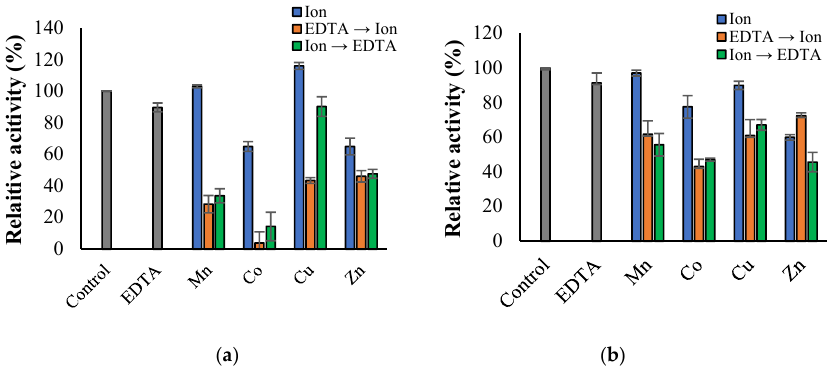
Figure 11. EDTA and metal ion effects on Est2L ( a ), and Est4L ( b ). The enzyme was preincubated with 1 mM EDTA or metal ions for 30 min, then 1 mM metal ions or EDTA were added respectively, and finally enzyme activities were measured. For the lipid hydrolysis activities, Est2L and Est4L hydrolyzed glyceryl tributyrate to 69.0% and 52.8% respectively, followed by trioctanoate to 77.9% and 71.9% respectively (Figure 12). It was confirmed that the hydrolyzing activities of fish oil, olive oil, and glyceryl trioleate by Est2L and Est4L were remarkably low. When based on glyceryl tributyrate as a substrate, Est4L showed a 25.1% higher hydrolyzing activity than